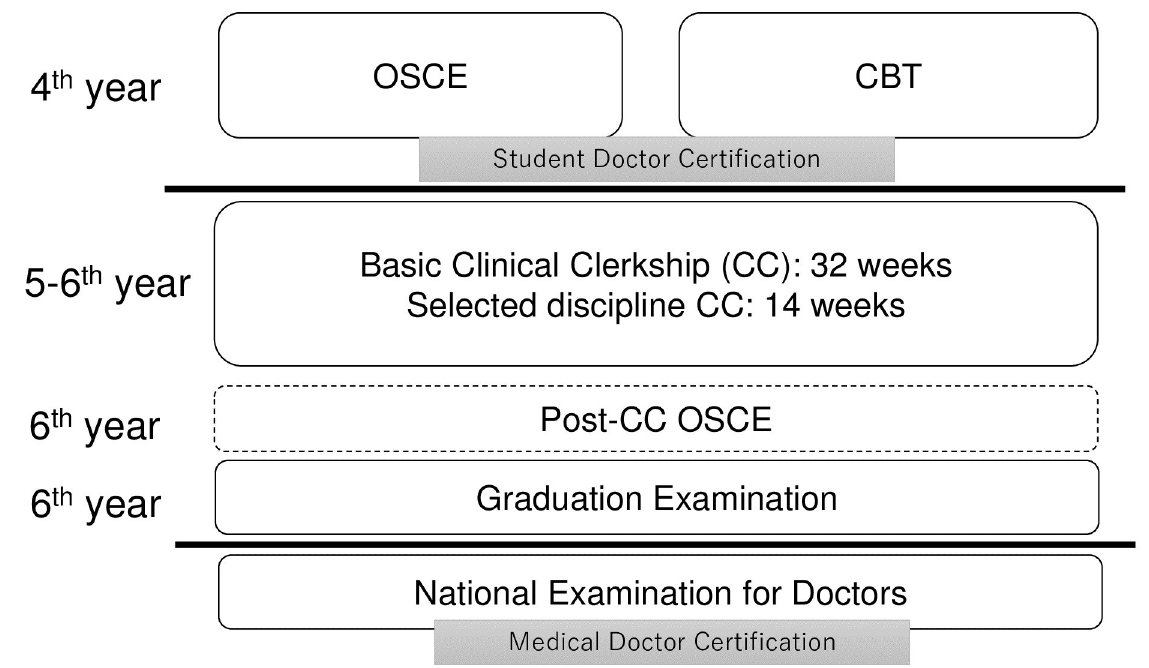
Fig 1. Schematic summarizing relationships between objective structured clinical examination (OSCE), computer-based testing (CBT), and clinical clerkships (CCs) at Osaka Medical College.